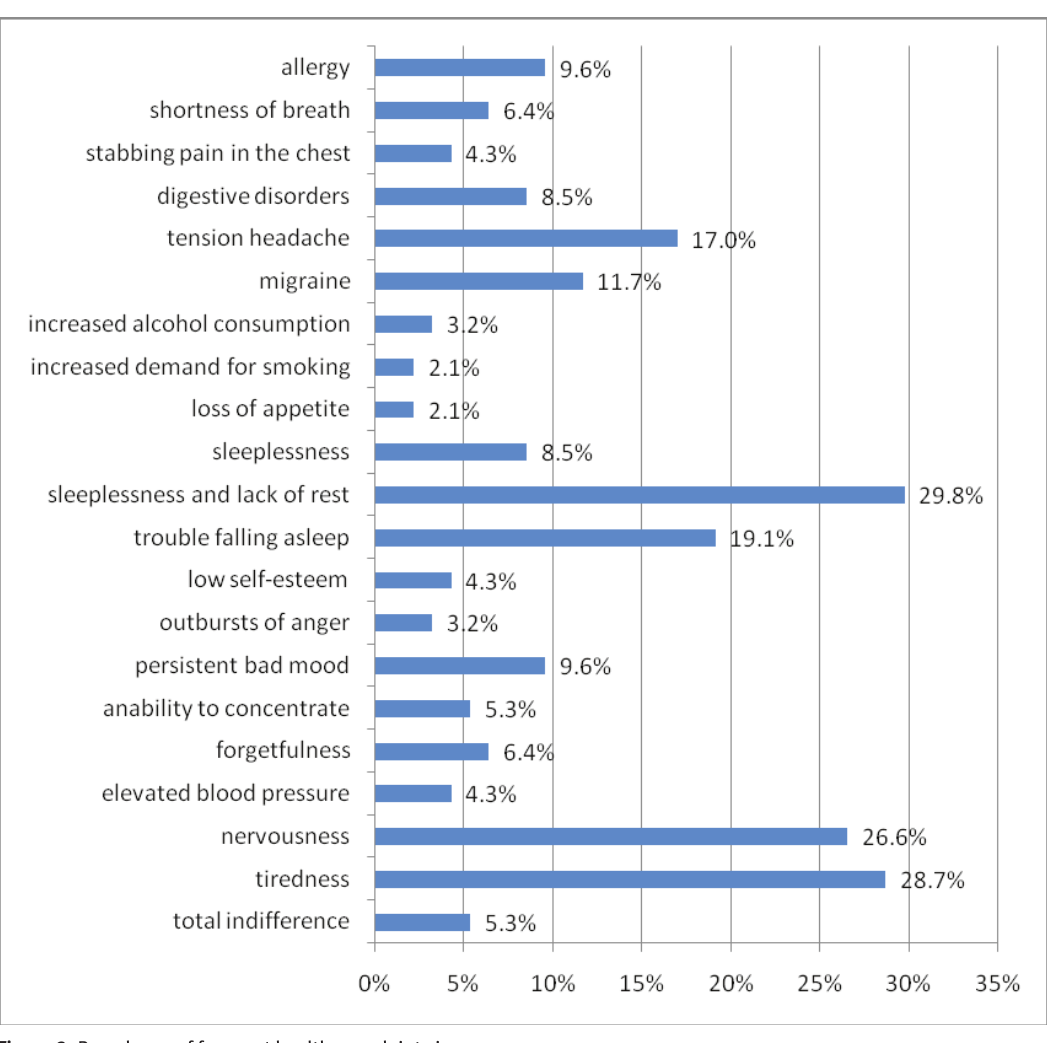
Figure 2: Prevalence of frequent health complaints in nurses. Table 2: Health complaints as predictors of professional burnout: logistic regression